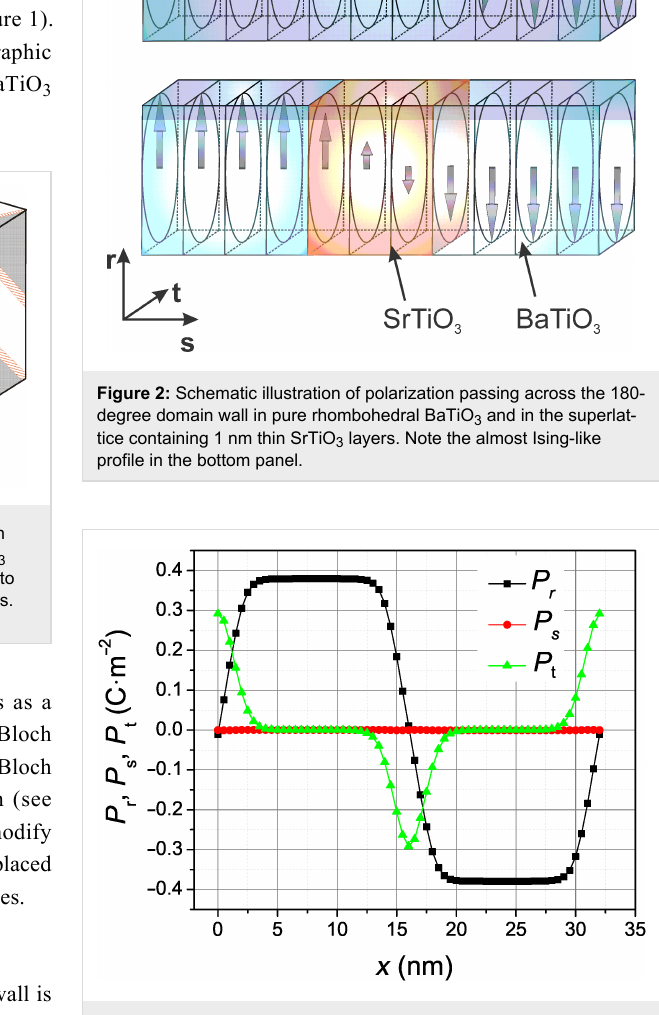
Figure 3: Relaxed profile of the polarization components across 180- degree ferroelectric wall in rhombohedral BaTiO 3